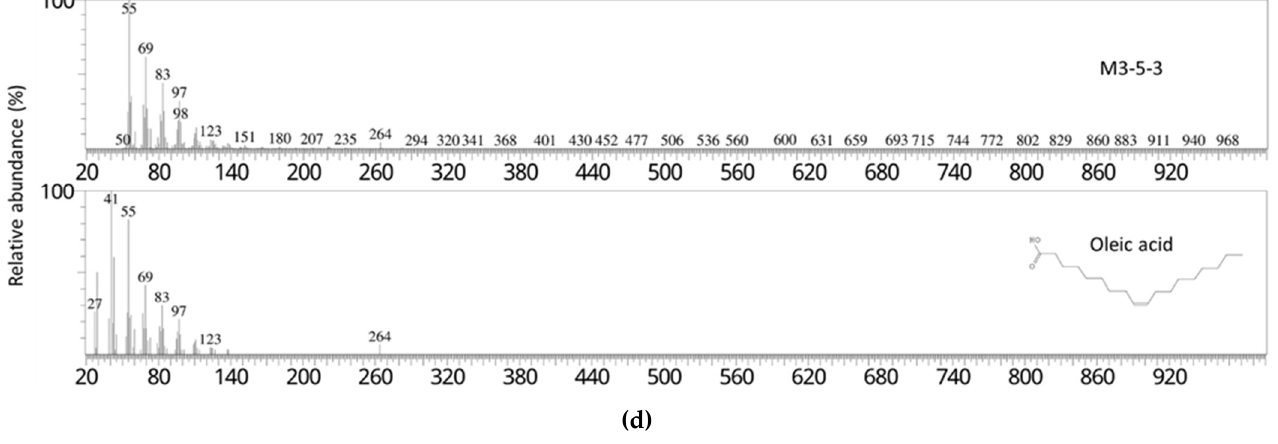
Figure 3. GC-MS analysis of the bioactive fractions against pancreatic lipase in vitro. ( a ) The TIC and EIC of fraction M3-5-2. ( b ) Mass spectra of fraction M3-5-2 (upper panel) and linoleic acid (lower panel). ( c ) The TIC and EIC of fraction M3-5-3. ( d ) Mass spectra of fraction M3-5-3 (upper panel) and oleic acid (lower panel).